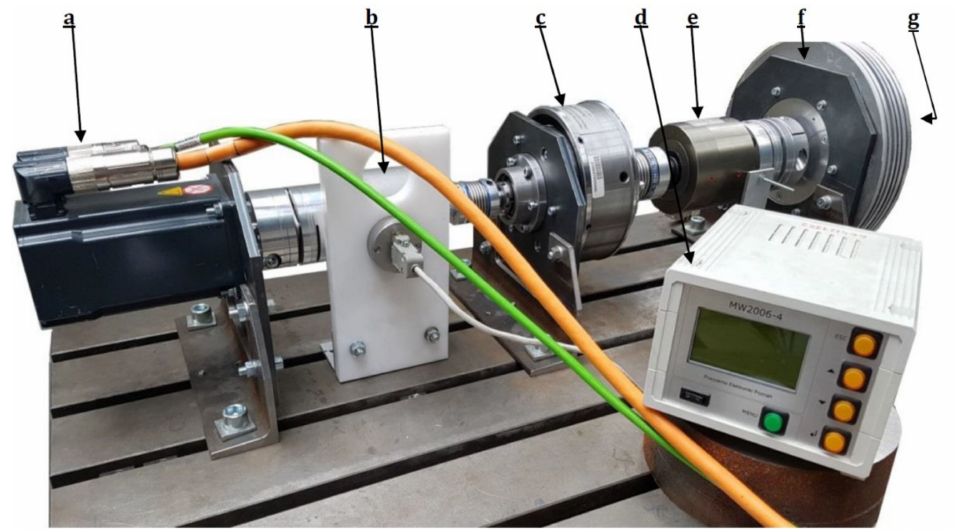
Figure 9. Overview of the test stand: a, servomotor; b, torque transducer 1; c, MPG prototype; d, torque-measuring interface; e, torque transducer 2; f, brake; and g, encoder.